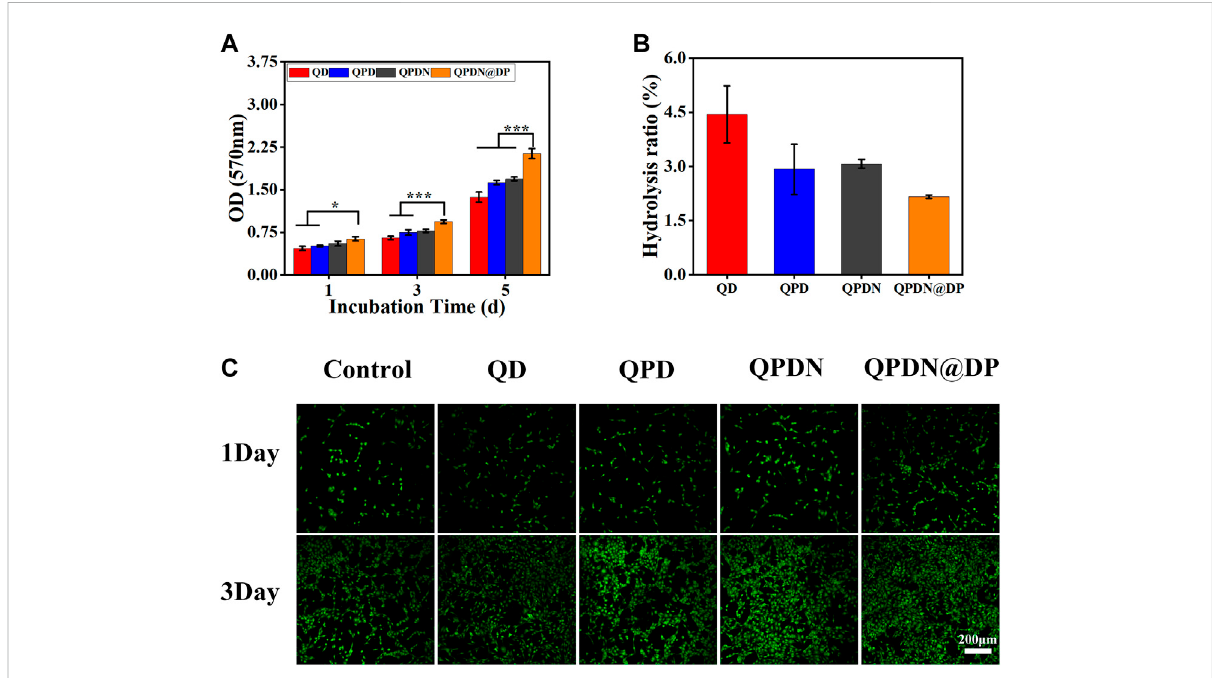
FIGURE 5 In vitro biocompatibility of hydrogels. (A) L929 cell viabilities after 1, 3, and 5 days incubation with leaching solution of hydrogels. (B) Hemocompatibilityofhydrogels. (C) Live/deadstainingresultsofL929cellsculturedfor1 – 3